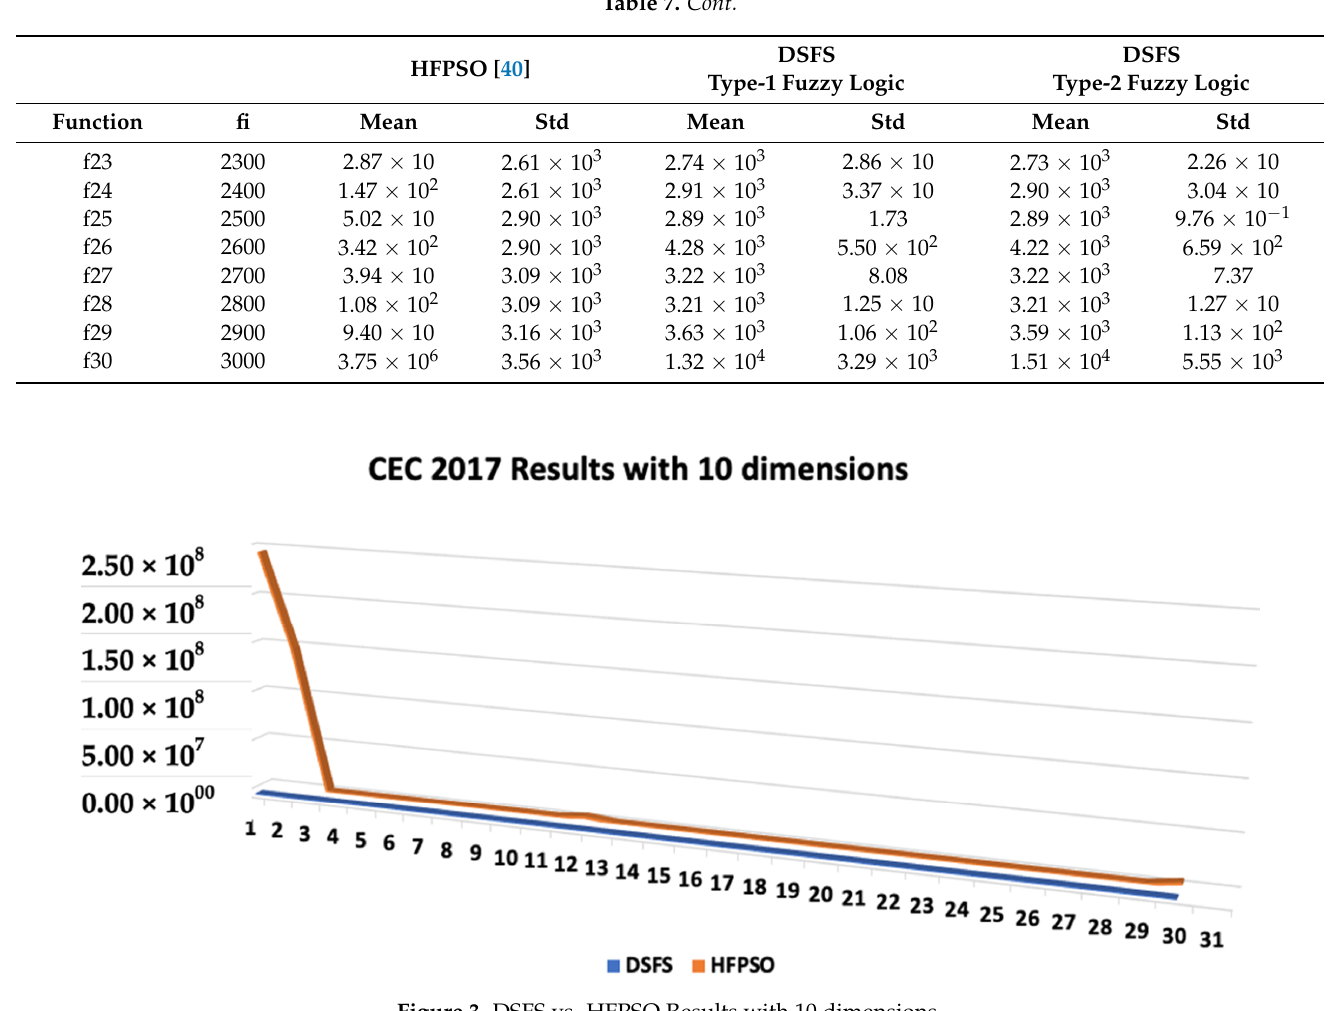
Figure 3. DSFS vs. HFPSO Results with 10 dimensions.